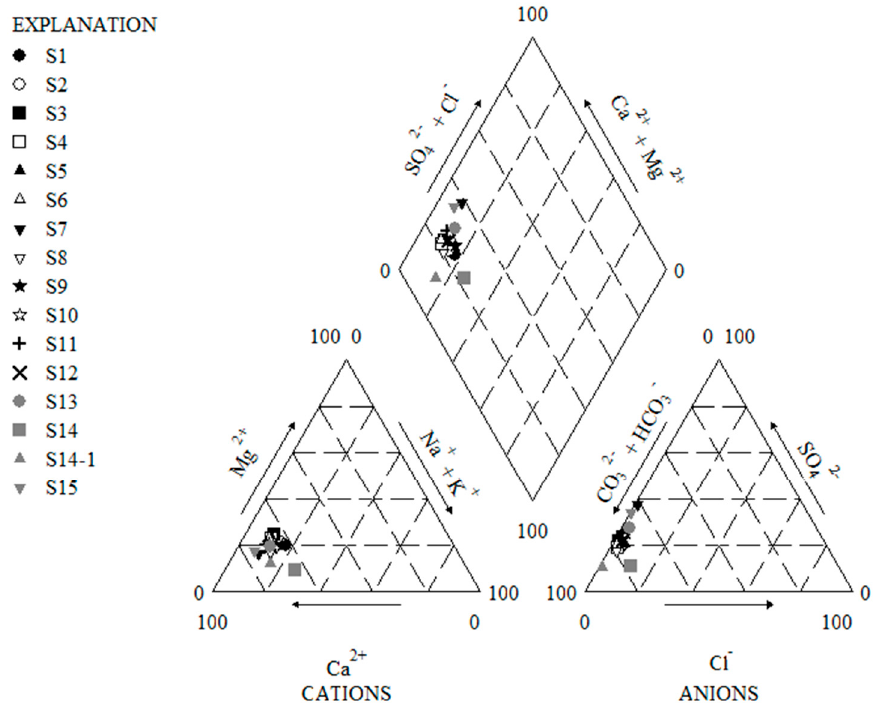
Figure 3. Piper diagram showing water samples collected from the Lhasa River.